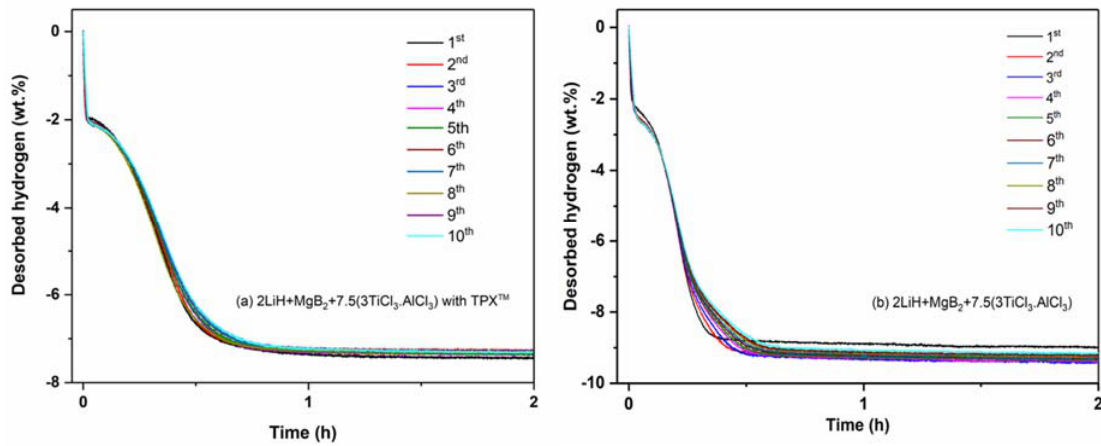
Figure 2. Dehydrogenation profiles and cycling capability of the composites Li-RHC d + 7.5(3TiCl 3 · AlCl 3 ) with TPX TM ( a ) and without TPX TM scaffold ( b ).